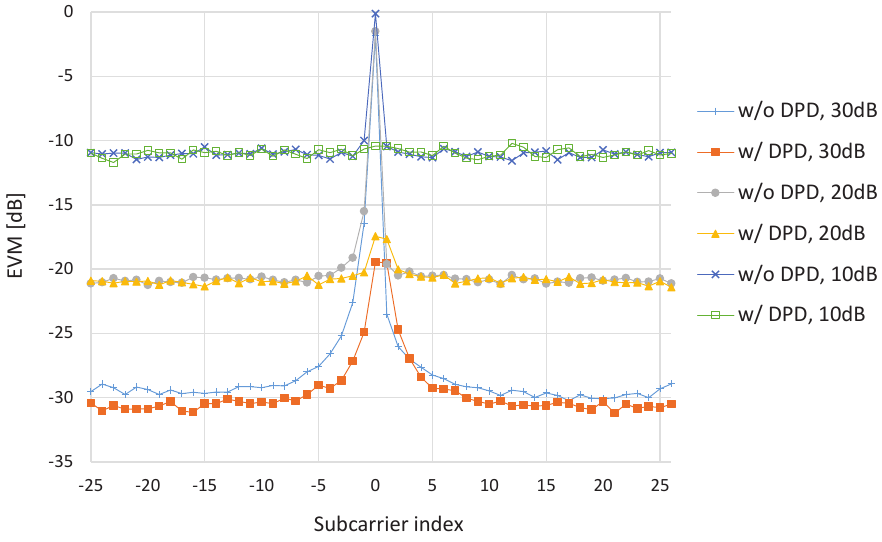
Figure 2. error vector magnitude (EVM) over subcarriers.